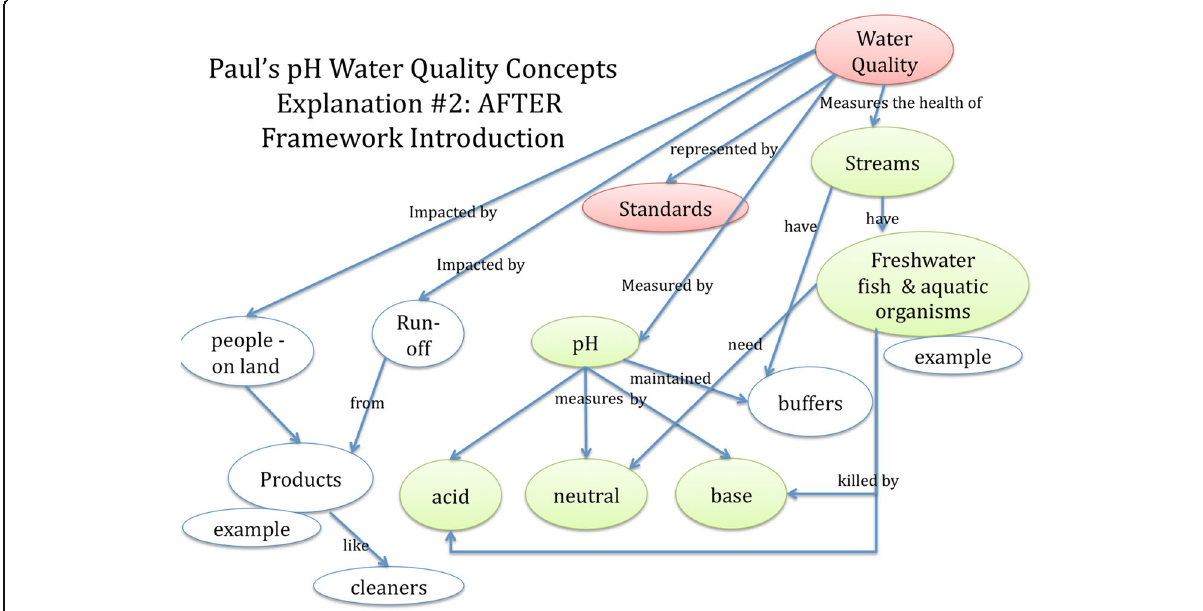
Fig. 3 Paul ’ s Explanation 2 (Ex2): Rubric Score - 3/6